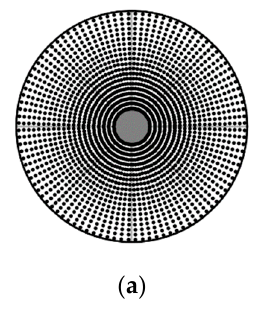
Figure 9. Sampling resolution used for calculating uniformity index: ( a ) n r = 20, n θ = 120; ( b ) n r = 5, n θ = 8; ( c ) n r = 5, n θ = 4; ( d ) n r = 2, n θ = 4.